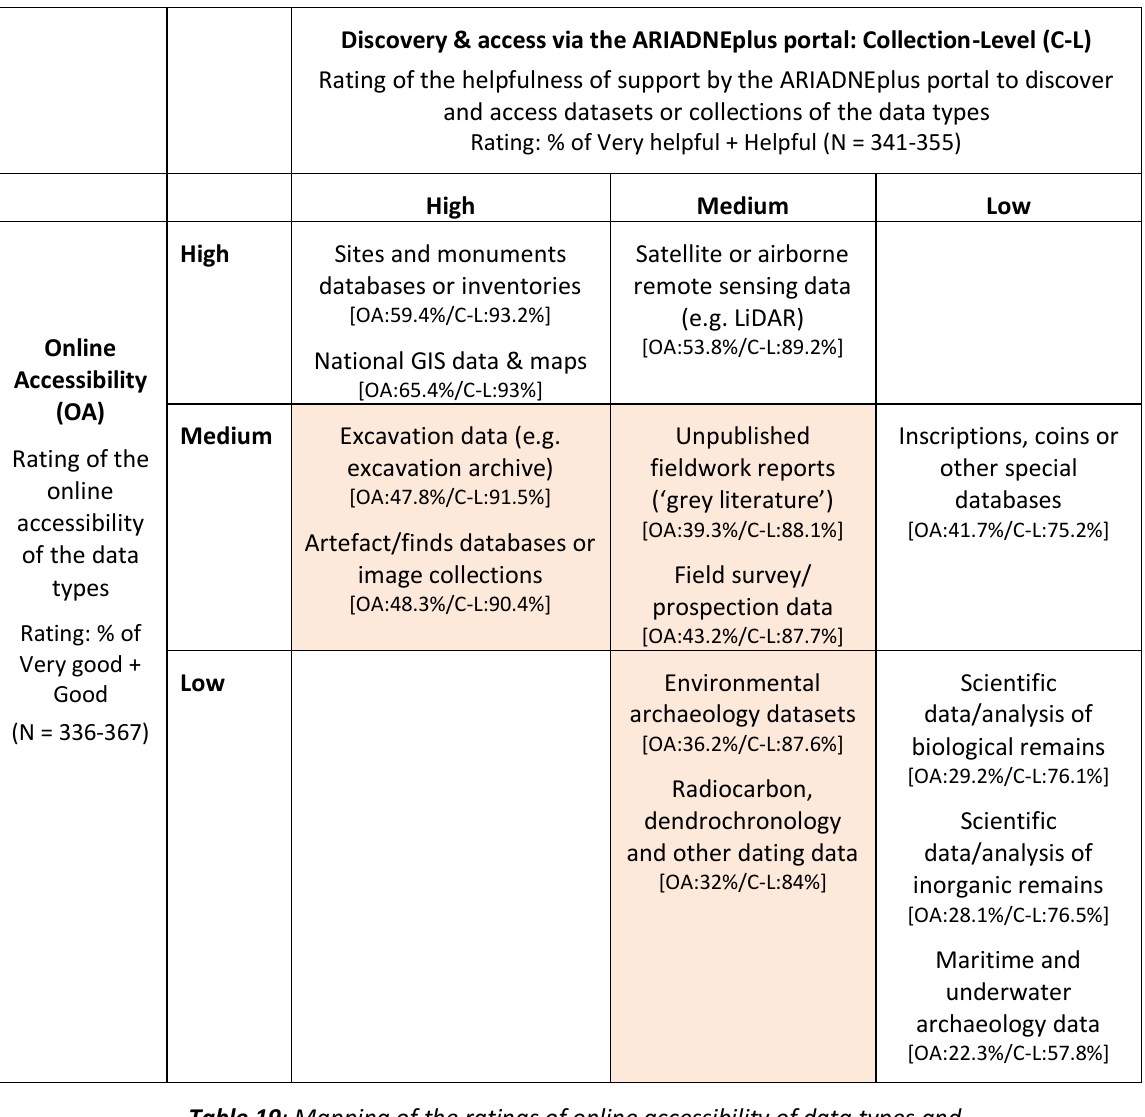
Table 19 : Mapping of the ratings of online accessibility of data types and portal support to discover and access datasets/collections of such